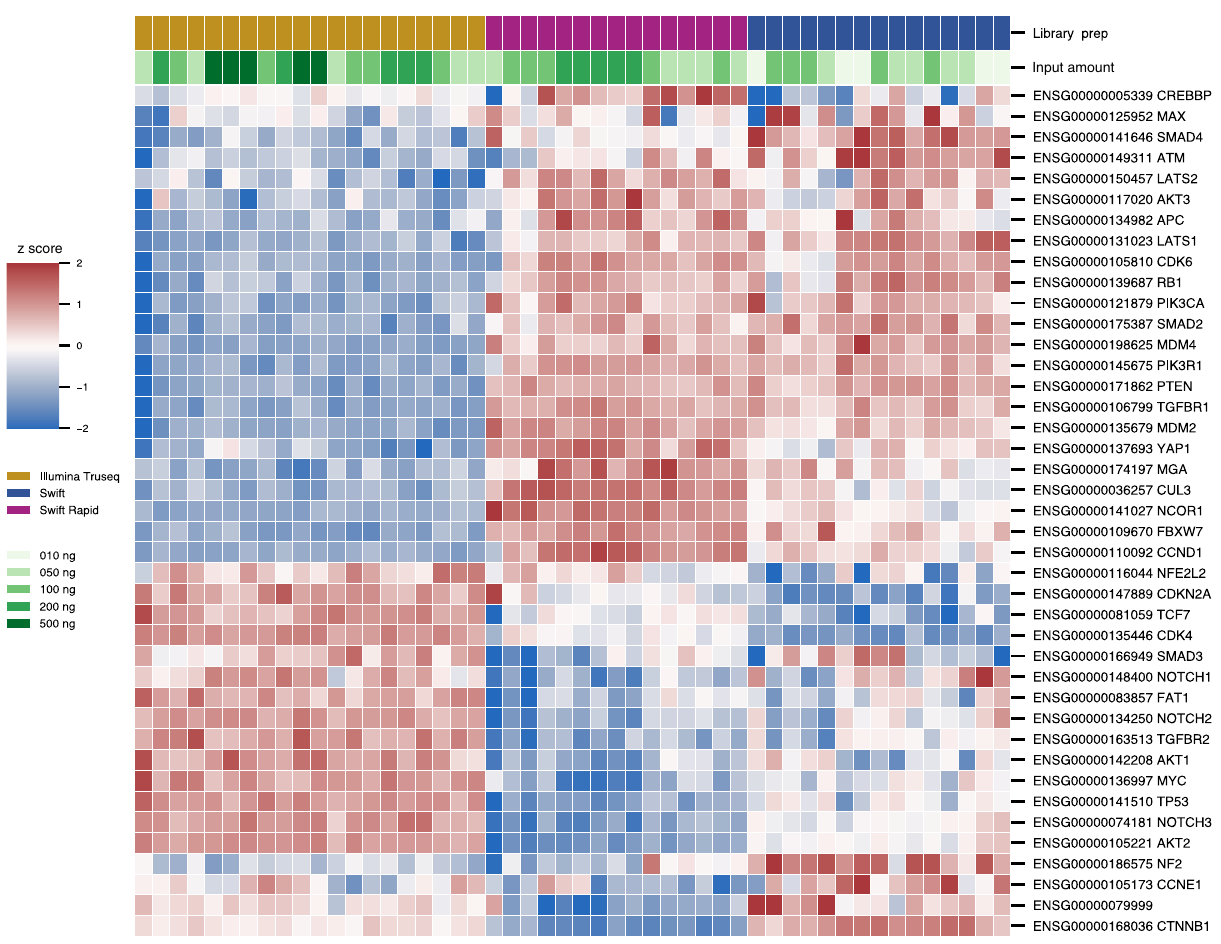
Figure 5. Standardized expression using regularized counts for oncogenic genes (rows) in each sample (columns). Red or blue boxes in the heatmap indicate that a gene’s expression in a sample is above or below the mean over all samples, by the indicated number of standard deviations, respectively. Rows and columns are hierarchically clustered using the Euclidean metric. The differences in gene expression are mostly within a single standard deviation from the